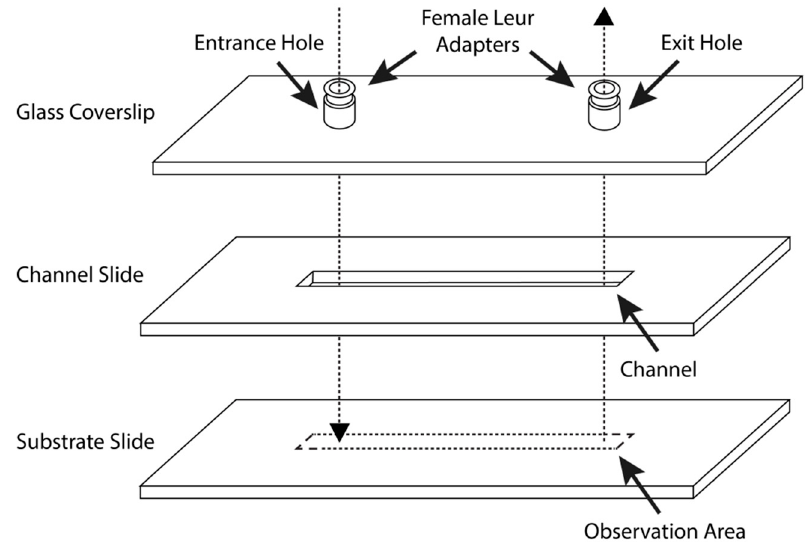
Figure 1. Schematic diagram of custom-made parallel-plate flow chamber.